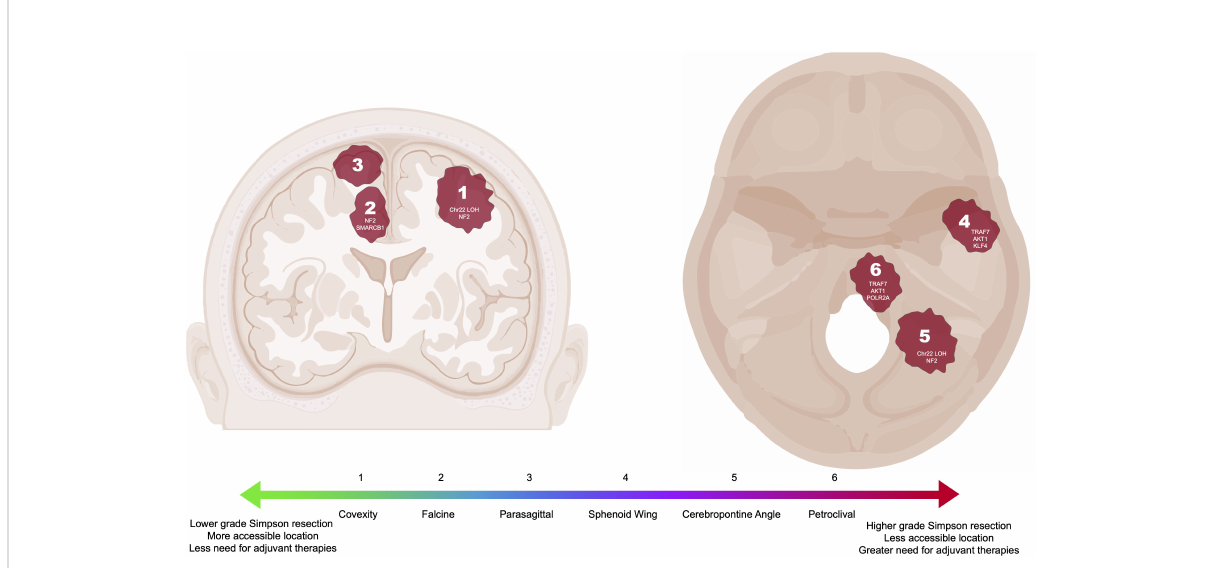
FIGURE 1 Common intracranial locations of meningiomas highlighted in this review with associated DNA driver mutations or chromosomal loss (6, 14, 23, 24). Locations correlated to a generalized scale ranging from less (green) to more (red) complicated to resect and manage. Meningioma locations not pictured include clinoid, foramen magnum, cavernous sinus, suprasellar, and